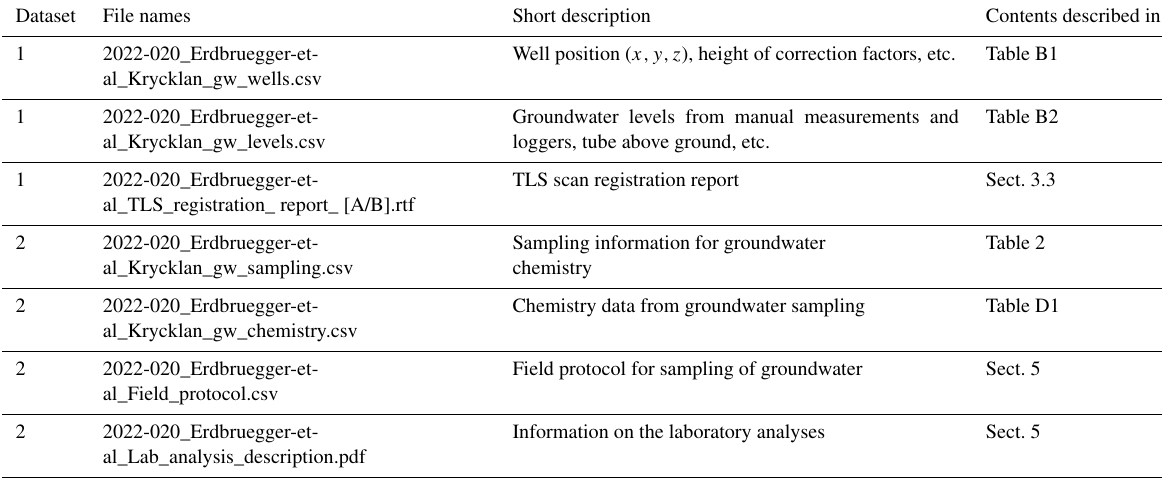
Table A2. Name and short description of the data files included in the two datasets.